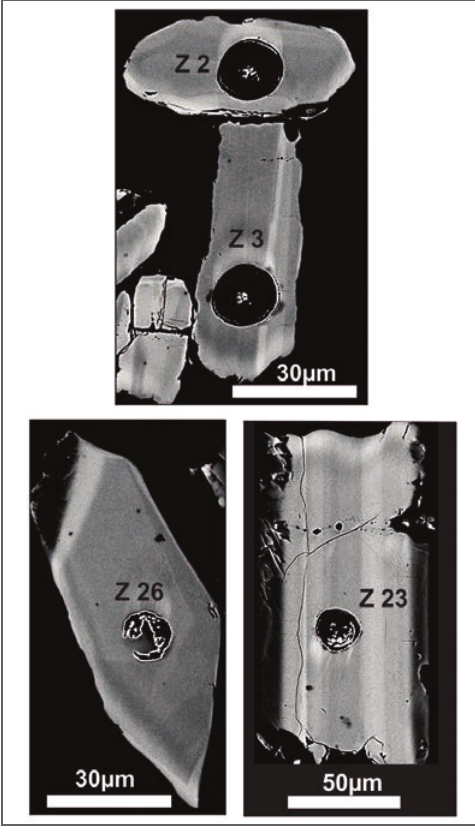
Figure 16 - Backscattered electron images representing the metagabbronorite zircons, exhibiting crystals with sinuous edges and often with corrosion gulfs (sample AR-75C).